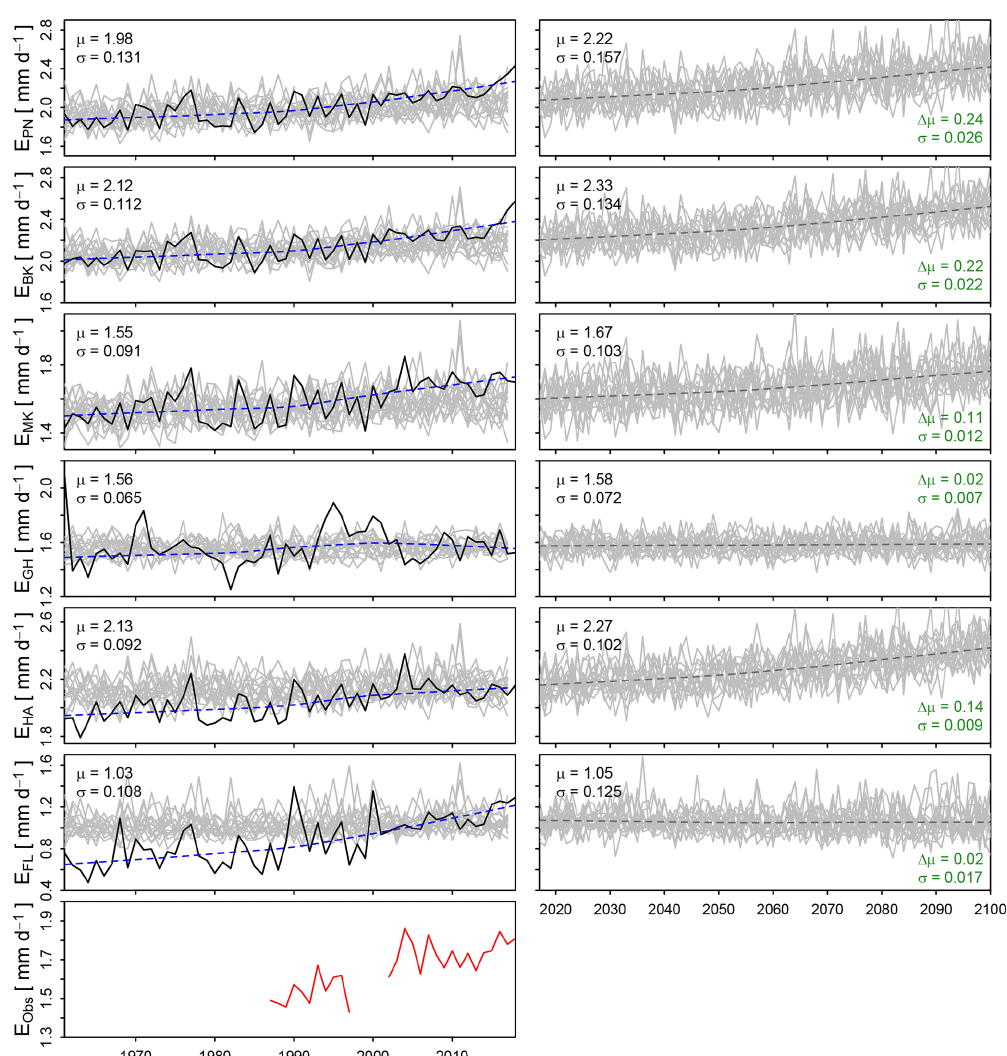
Figure 5. Trends of simulated evaporation for the historical and future periods. Black line indicates yearly averaged simulated historical evaporation rates based on data from De Bilt. The dotted blue line represents the trend in this line. The grey lines indicate the yearly averaged simulations from RACMO climate projections. Mean and standard deviation of the RACMO simulations are given in each panel in black. The differences of these statistics between the historical and future periods are given in green. In the lowest panel the yearly averaged observed evaporation at meteorological site Cabauw is presented in